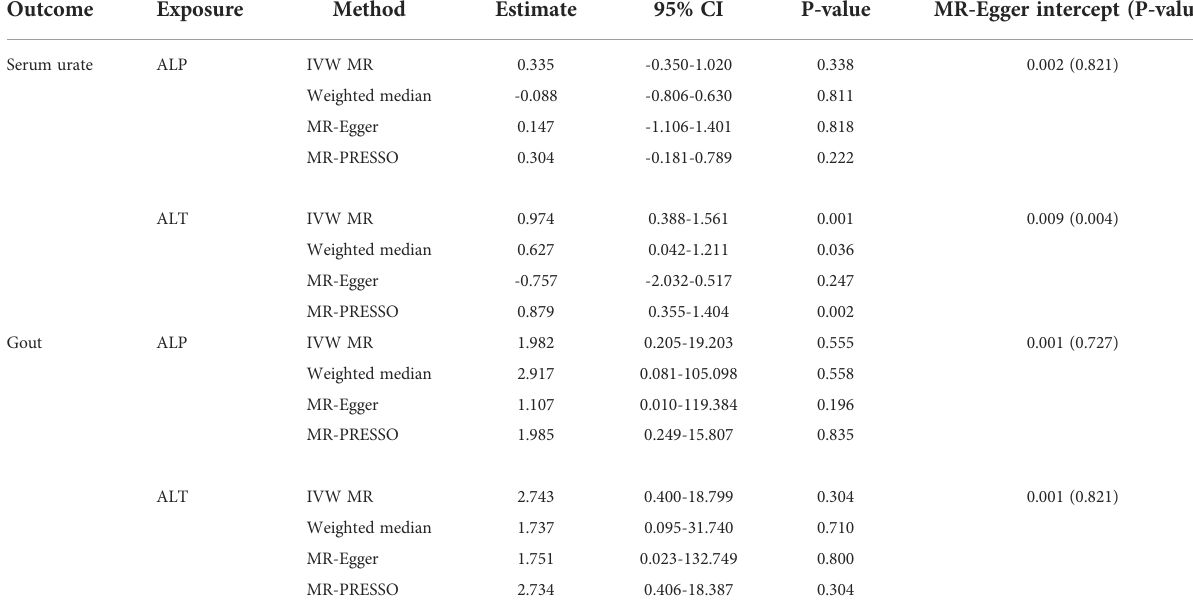
TABLE 6 Mendelian randomization estimates of liver function on serum urate or gout.